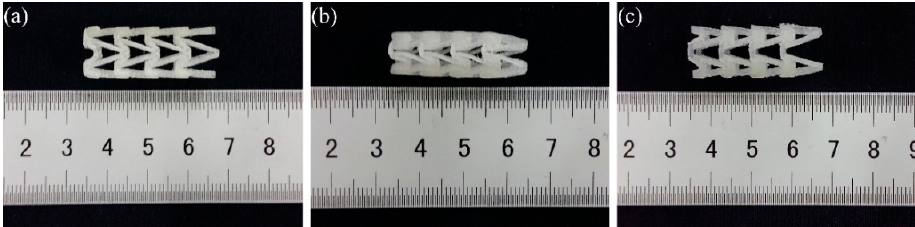
Figure 6. Shape change of numbered B1 3D-printed PLA vascular stent with NPR structure, ( a ) Original PLA stent; ( b ) Crimped PLA stent; ( c ) Recovery PLA stent.